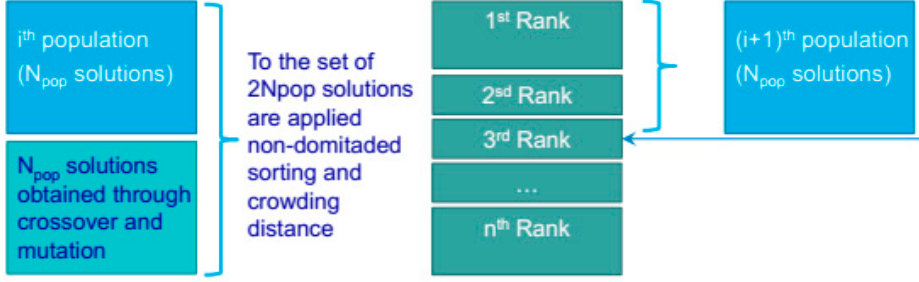
Figure 9. i-th iteration of the optimization algorithm [29,31].